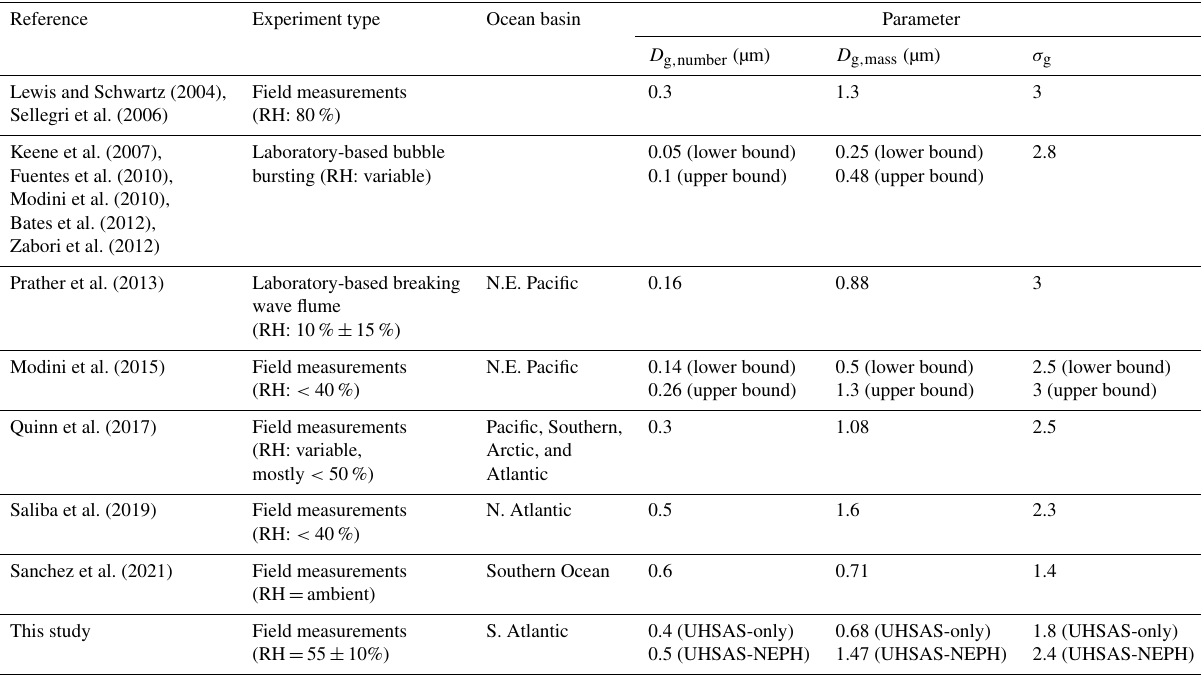
Table 6. Values of sea spray modal parameters reported in the literature. Number mean diameters ( D g , number ) were converted to mass mean diameters ( D g , mass ) using Eq. (7), integrating over particle sizes of 0.01–10µm and averaging over a total particle concentration range of 1–100cm − 3 . Values are averages unless labeled as an upper or lower